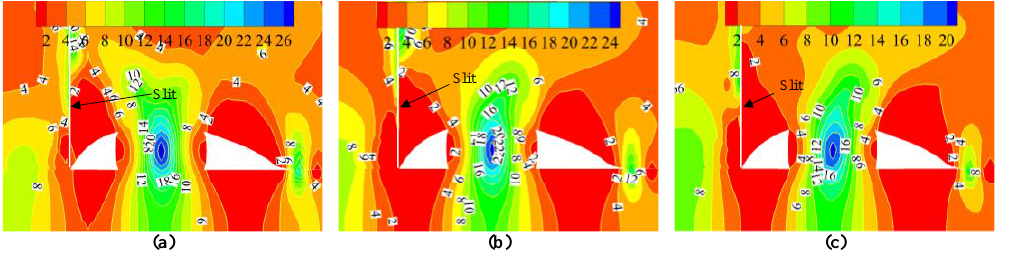
Figure 11. Nephogram of vertical stress distribution of surrounding rock with different top cutting heights: ( a ) H = 6 m; ( b ) H = 8 m; ( c ) H = 10 m.